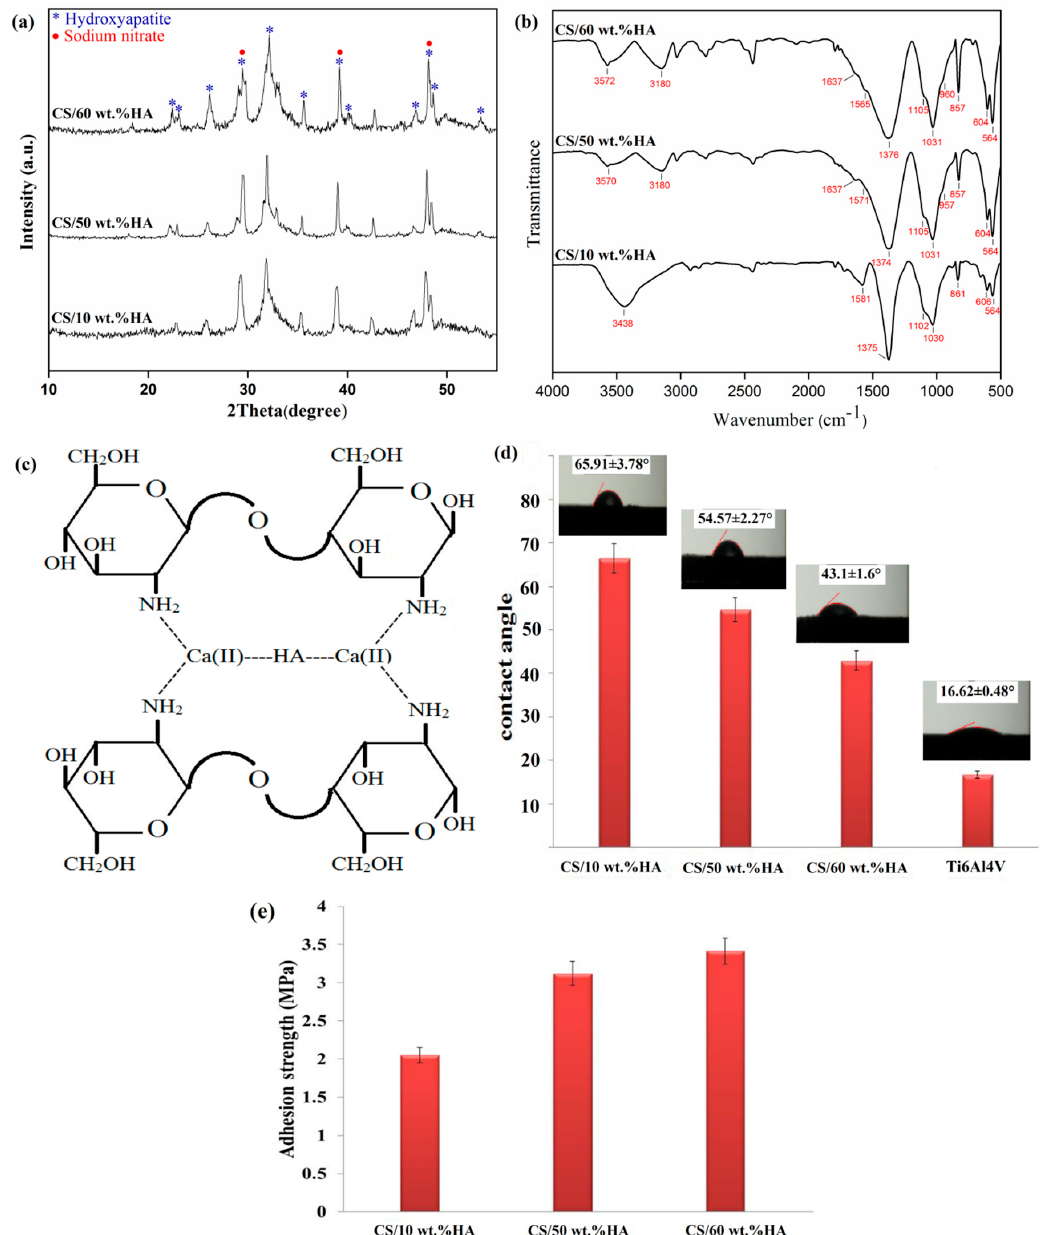
Figure 3. ( a ) XRD patterns and ( b ) FTIR spectra of CS / HA with 10, 50 and 60 wt.% of HA ( c ) Interaction between Ca 2 + of HA and –NH 2 of chitosan ( d ) Contact angle between the water drop and the sample surfaces ( e ) Adhesion strength of the CS / HA coatings.